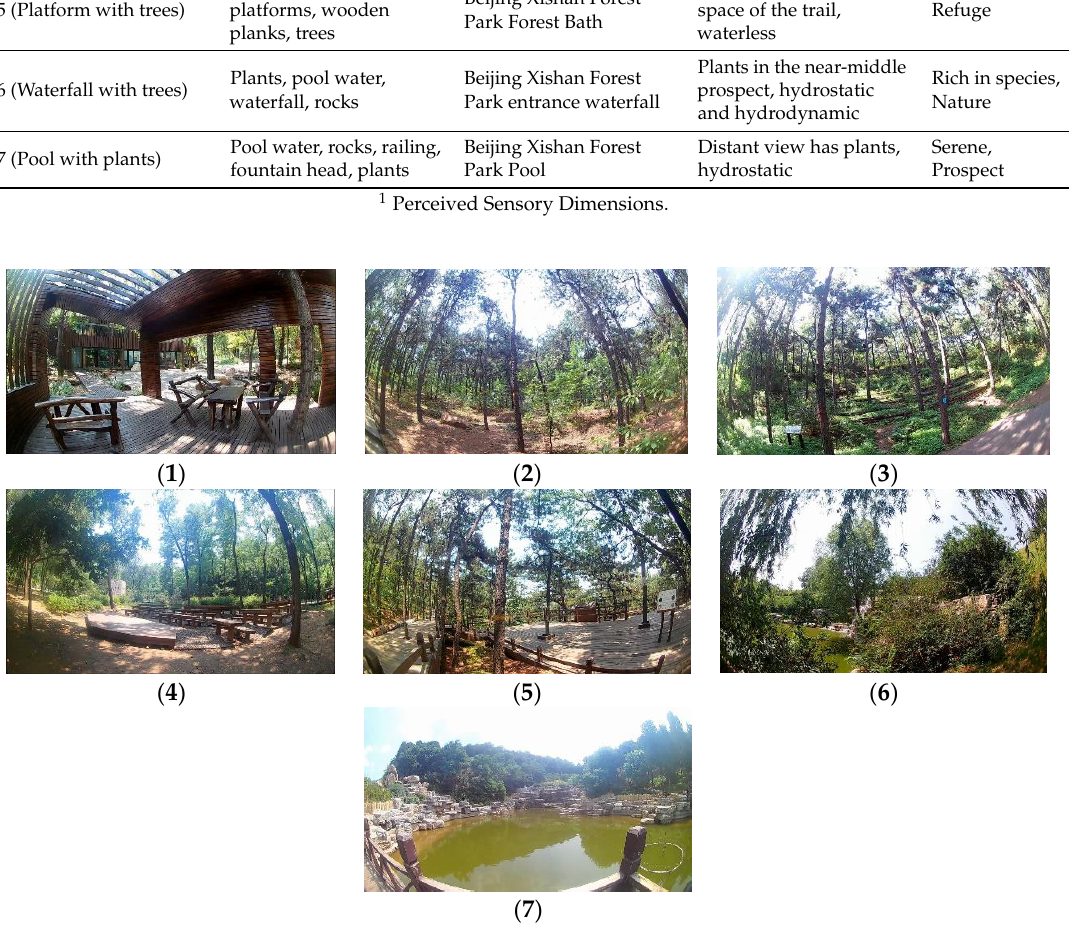
Figure 1. The videos of seven different types of forest resting environments: ( 1 ) structure, ( 2 ) wood, ( 3 ) wood with bench, ( 4 ) wood with platform and bench, ( 5 ) platform with trees, ( 6 ) waterfall with trees, and ( 7 ) pool with plants.